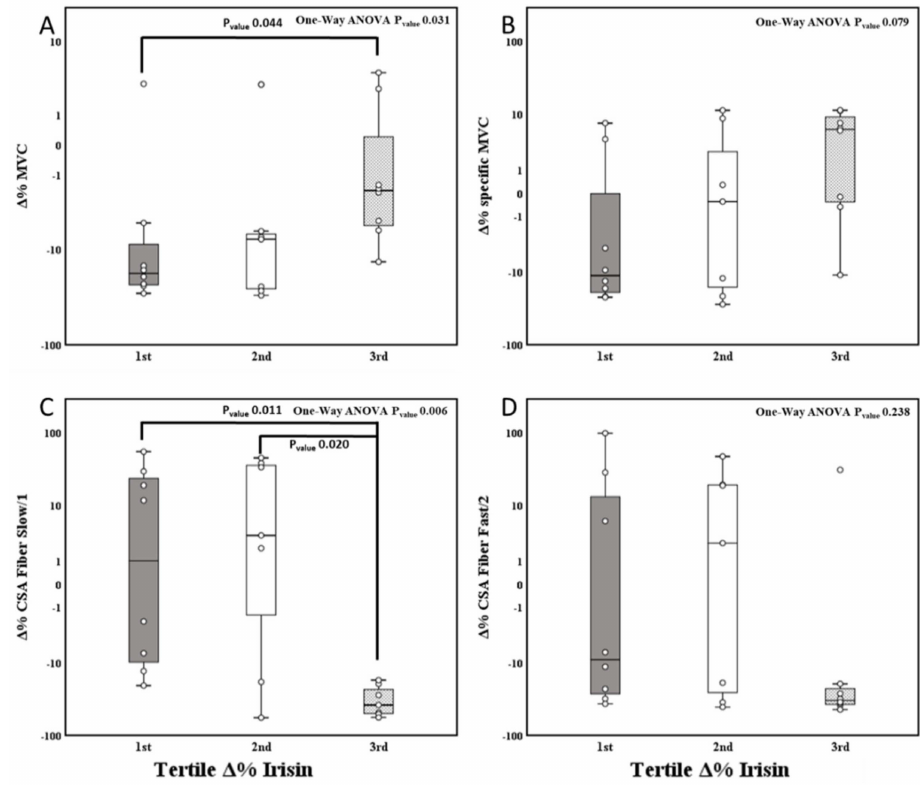
Figure 3. One-way analysis of variance for tertile irisin variation (percentage difference of the variables between BR14 and BDC) and muscle performance variation (percentage difference of the variables between BR14 and BDC). In the different panels are described for tertile ∆ Irisin (mg/L) BR14 vs. BDC (%) the means (95% CI) of ( A ): ∆ MVC(%); ( B ): ∆ specific MVC(%). ( C ): ∆ CSA Fiber Slow/1(%); panel ( D ): ∆ CSA Fiber Fast/2. BDC, baseline data collection; BR14, after 14-day Bed Rest data collection; ∆ % variable, percentage difference of the variables of interest between BR14 and BDC; MVC, maximal voluntary contraction; Specific MVC, ratio between MVC and QMV; CSA, cross-sectional